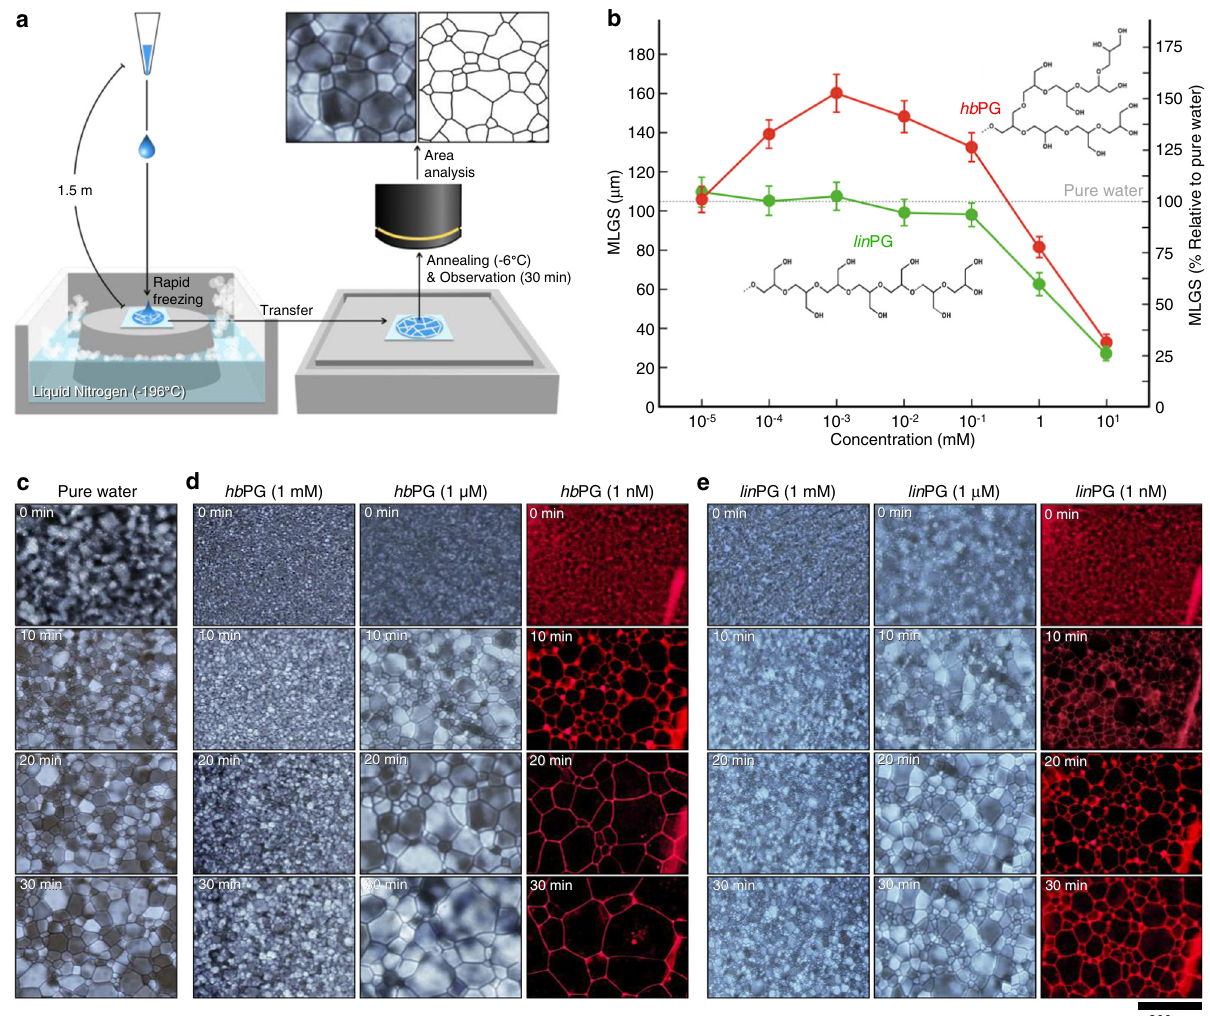
c pure water, d hb PG, and e lin PG during ice recrystallization. Corresponding fl uorescence images of the ice domain with Cy5-conjugated hb PG ( d , right panels) and lin PG( e ,rightpanels).Cy5-conjugatedPGs,whichwerelocatedattheinterface between the ice domains, moved along the interfacial locus over time. The scale bars represent 200 µ m. Error bars indicate standard